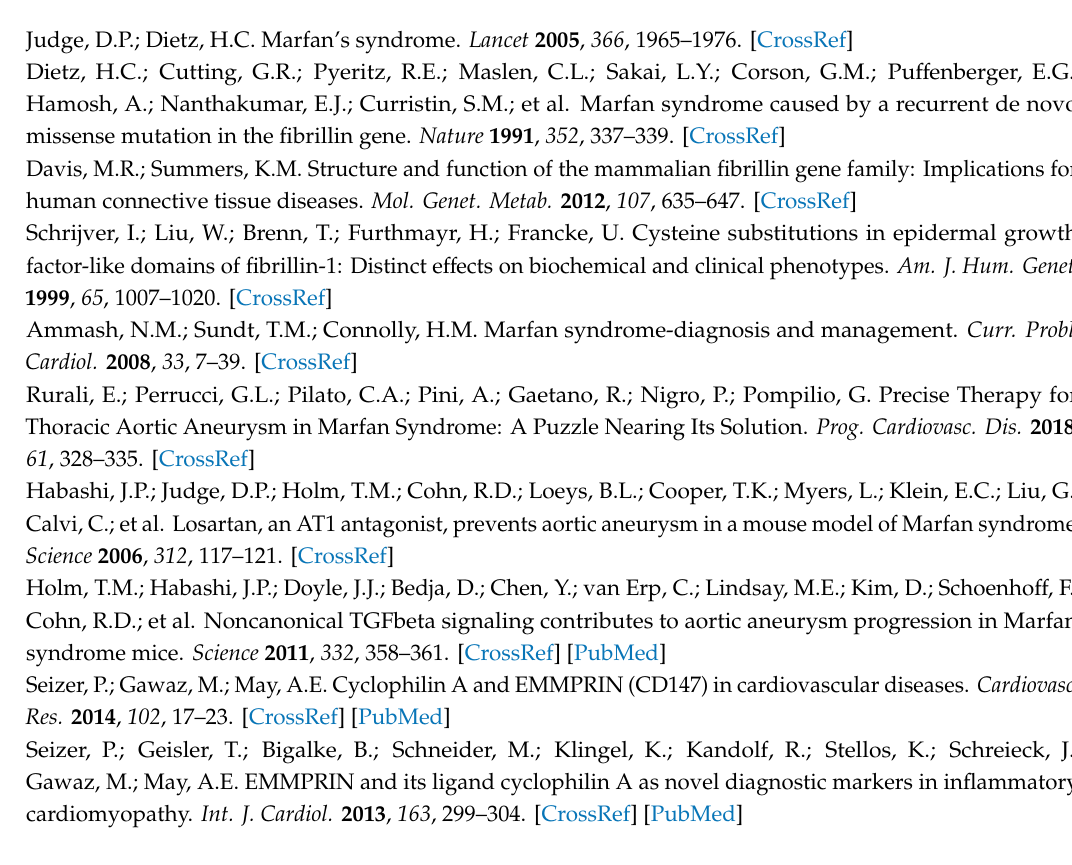
Figure 7. Proposed mechanism of CyPA / EMMPRIN axis involvement in TAA associated with MFS.The ECM of thoracic aorta in MFS patients is characterized by fragmented fibrillin-1, which determines TGF- β 1 release. Active TGF- β 1 binds its receptor and stimulates both the SMAD2 / 3 (canonical) and ERK1 / 2 (non-canonical) pathways, leading to the transcription and translation of pro-fibrotic factors, such as collagen and TGF- β 1 itself. AngII stimulus leads to the secretion of CyPA, which binds its receptor EMMPRIN. The CyPA / EMMPRIN axis triggers (i) ERK1 / 2 pathway (non-canonical signaling, shared with TGF- β 1), (ii) EMMPRIN, which, in turn, induces MMP activation, and (iii) the expression of typical downstream ERK1 / 2 pro-fibrotic mediators, involved in tissue remodeling of MFS-associated TAA. The inhibitor MM284 reverses all the deleterious e ff ects of CyPA in MFS-VSMC. Supplementary Materials: The following are available online at http: // www.mdpi.com / 2073-4409 / 9 / 1 / 154 / s1, Figure S1: Cells isolated from aortic tunica media are VSMC and express CyPA and EMMPRIN; http: // www. mdpi.com / 2073-4409 / 9 / 1 / 154 / s2, Figure S2: CyPA is localized into the cytoplasm of VSMC; http: // www.mdpi. com / 2073-4409 / 9 / 1 / 154 / s3, Figure S3: CyPA does not alter cell proliferation and does not induce apoptosis in MFS-VSMC; http: // www.mdpi.com / 2073-4409 / 9 / 1 / 154 / s4, Figure S4: CyPA / EMMPRIN axis inhibition decreases MMP expression and activity in